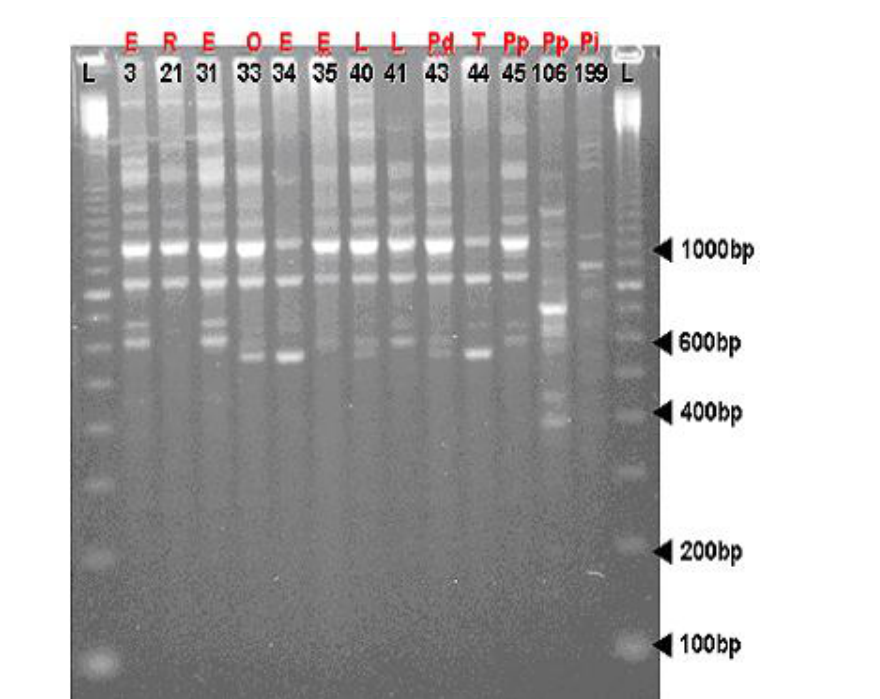
Figure 1. Gel electrophoresis and dendrogram of the RAPD profiles obtained from Klebsiella oxytoca isolates with primer Operon